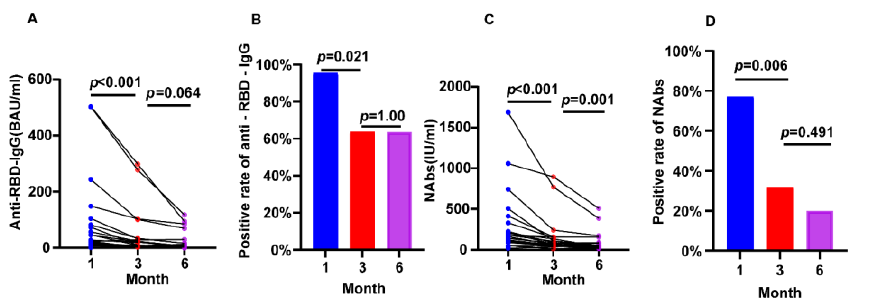
Figure 2. Longitudinal changes of humoral immune responses following immunization with vaccines in CKD patients. ( A ) The change of serum anti-RBD-IgG levels. ( B ) The change of seropositivity rates of anti-RBD-IgG. ( C ) The change of serum NAbs levels. ( D ) The change of seropositivity rates of NAbs. The IQR are indicated by error bars. anti-RBD-IgG, spike receptor-binding domain IgG antibody; CKD chronic renal disease; NAbs neutralizing antibodies.